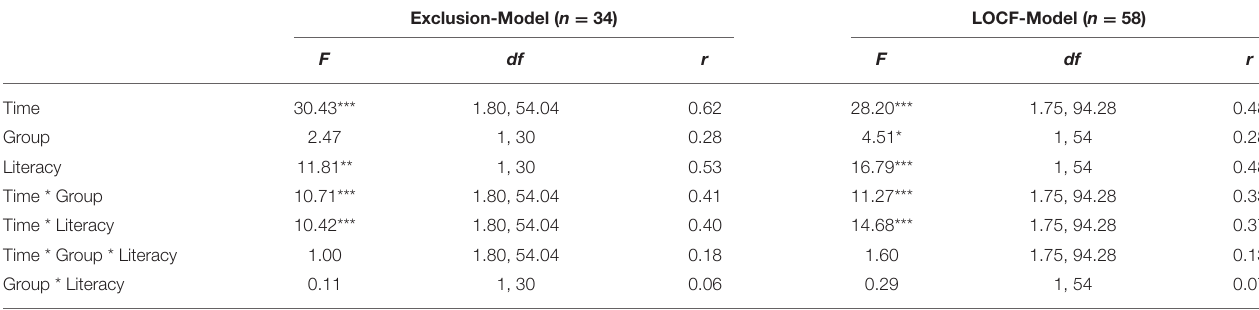
TABLE 6 | Summary of the exclusion-model and the LOCF-model for achievements in the German CEFR level in the experimental group and control